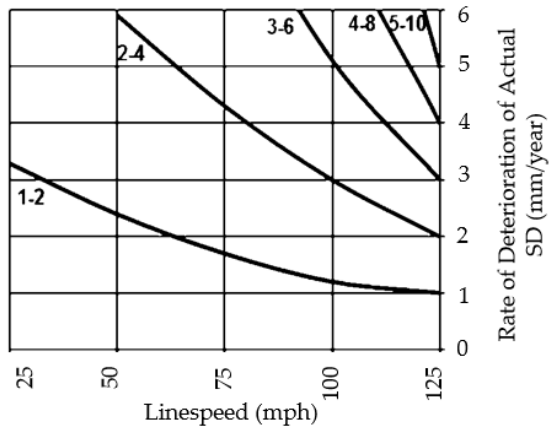
Figure 7. Indicative value of threshold recording frequency.